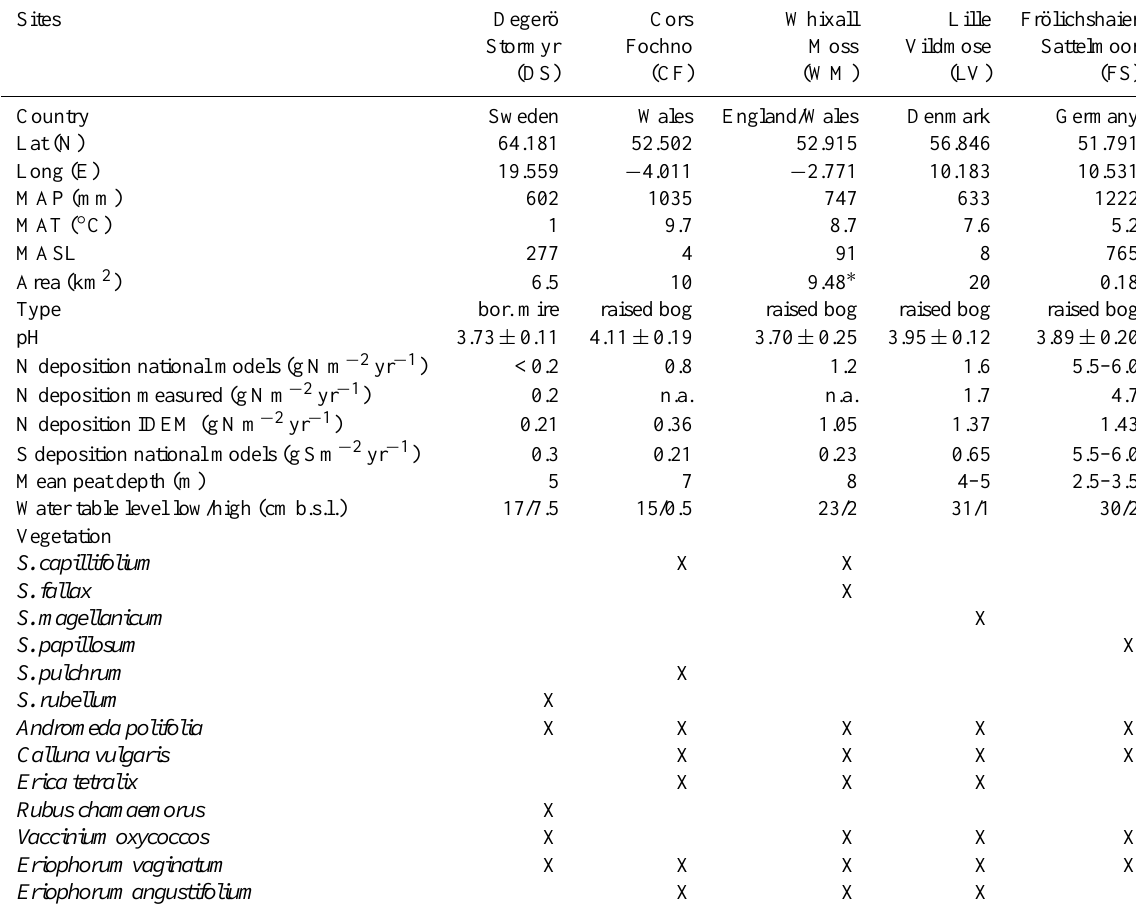
Table 1. Characteristics of the sampled peatlands. Sites